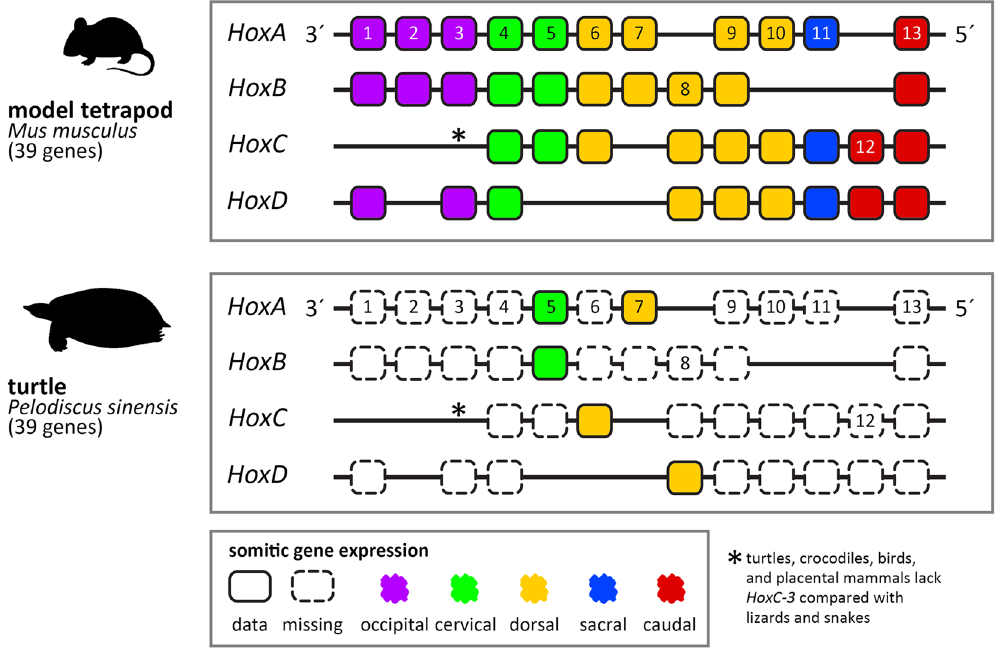
Figure 3. Hox gene inventory. Overview of the Hox gene inventory of the mouse Mus musculus and of the turtle Pelodiscus sinensis (information based on Liang et al . 2011) with indication of current knowledge of somitic Hox gene expression (information based on Ohya et al . 2005). The mouse is the most thoroughly studied animal concerning Hox gene expression and serves as model for tetrapods in general. The 39 Hox genes in tetrapods are arranged on four different chromosomes in four clusters ( HoxA , B , C , D ). The color coding indicates how gene groups map to the axial